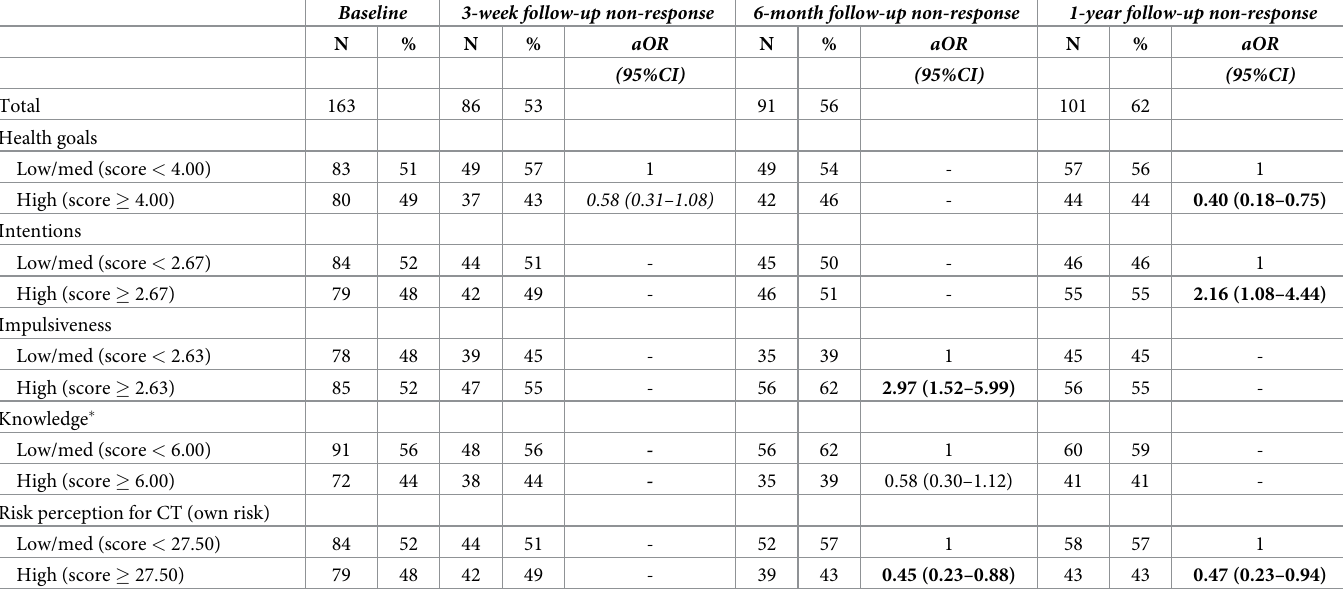
Table 3. Multivariable logistic regression analyses of predictors of non-response at the three follow-up data collection moments for participants who visited the STI clinics in Kennemerland, Hollands Noorden, and Twente (non-Amsterdam).